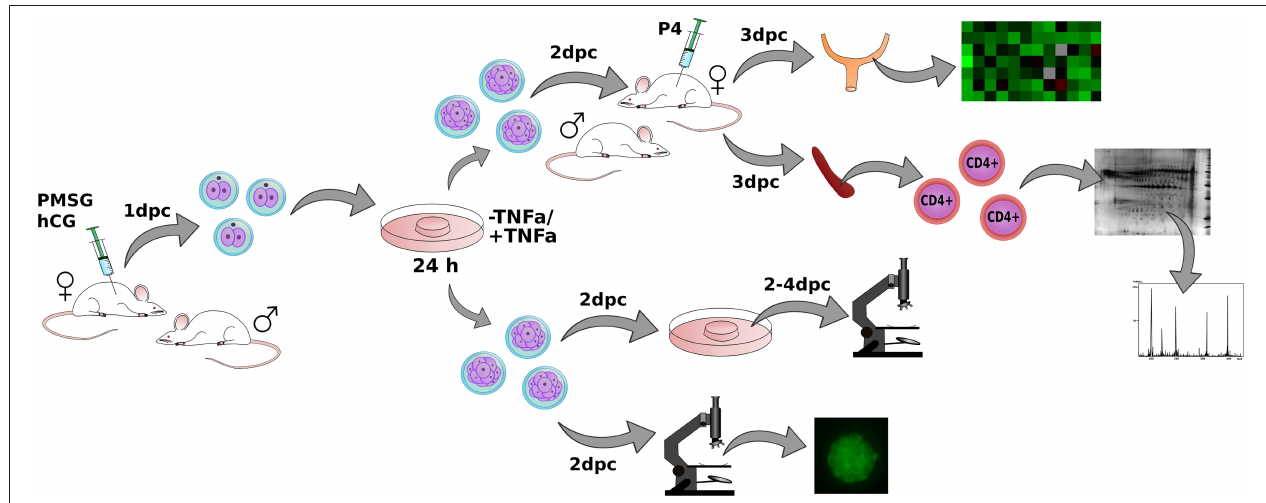
FIGURE 1 | The layout of the entire experiment. Female mouse donors were superovulated by PMSG (Pregnant Mare Serum Gonadotropin) and hCG (human Choriogonadotropin) injections and mated with fertile males. Embryos were collected at the 1st day post-coitum (dpc) and cultured for the next 24h in the presence or without TNF α . Embryos were transferred into progesterone-treated and mated with vasectomized males, female recipients. Uteri and spleens from recipient females were dissected. Gene expression and proteome of CD4 + lymphocytes were examined in obtained tissues. A separate group of embryos was examined in vitro for checking the developmental progress and phosphatidylserine